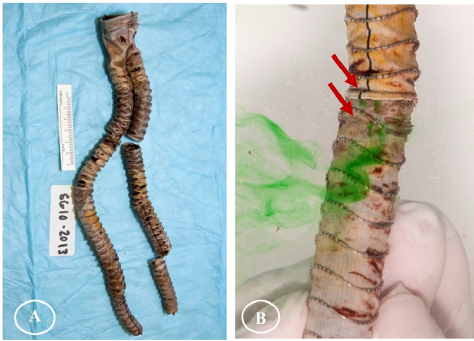
Figure 2. The phenomenon of twisting is well evidenced in an explanted thoracic Zenith stent ‐ graft ( A : arrows); showing some fluid percolation at the twisting site ( B : arrows).